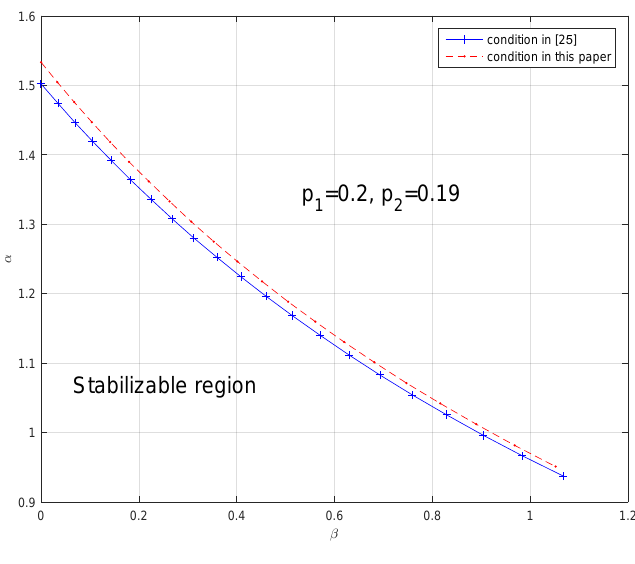
Figure 5. Stabilizability region of system (50).